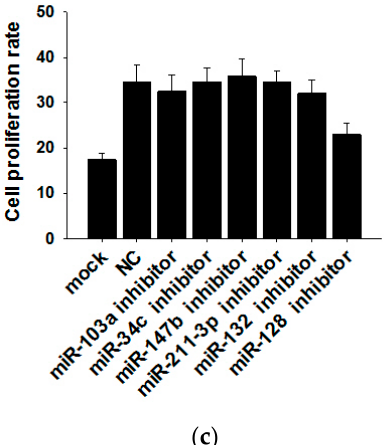
Figure 4. Exosomal miR-128 promotes MCF-7 cell proliferation. ( a ) Microarray analysis of exosomal and cellular miRNAs from MCF-7 cells. The panel shows the heat map of the per-row normalized expression levels of secreted miRNAs differentially expressed in cells versus exosomes; ( b ) MiRNA inhibitors can effectively knockdown the levels of six miRNAs in exosomes (the MI group is the miRNA inhibitors of miR-103a, miR-34c, miR-147b, miR-211-3p, miR-132 and miR-128; the NC group is transfected with NC inhibitor, which has the same amount as the basic group but a different sequence from those miRNAs); ( c ) Effects of exosomal miR-128 on MCF-7 cell proliferation (mock group is with no treatment; NC group is transfected with NC inhibitor. ** p < 0.01.